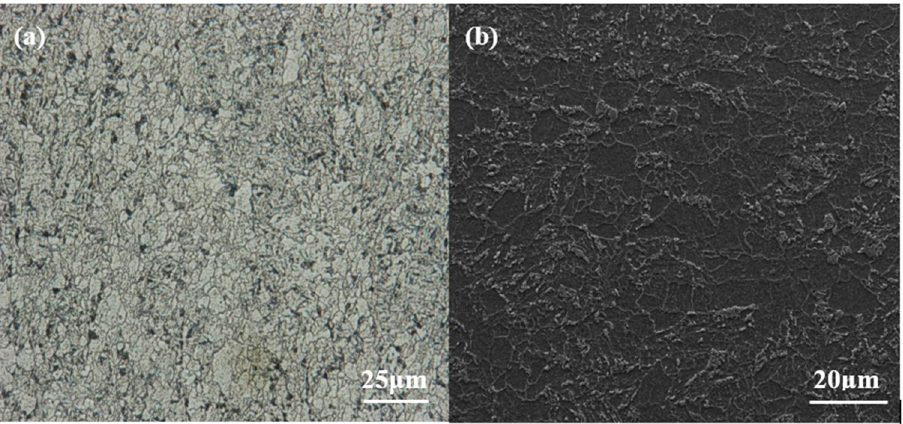
Figure 1. Microstructural images of the X70 pipeline steel: ( a ) metallograph and ( b ) scanning electron microscope (SEM) diagram.